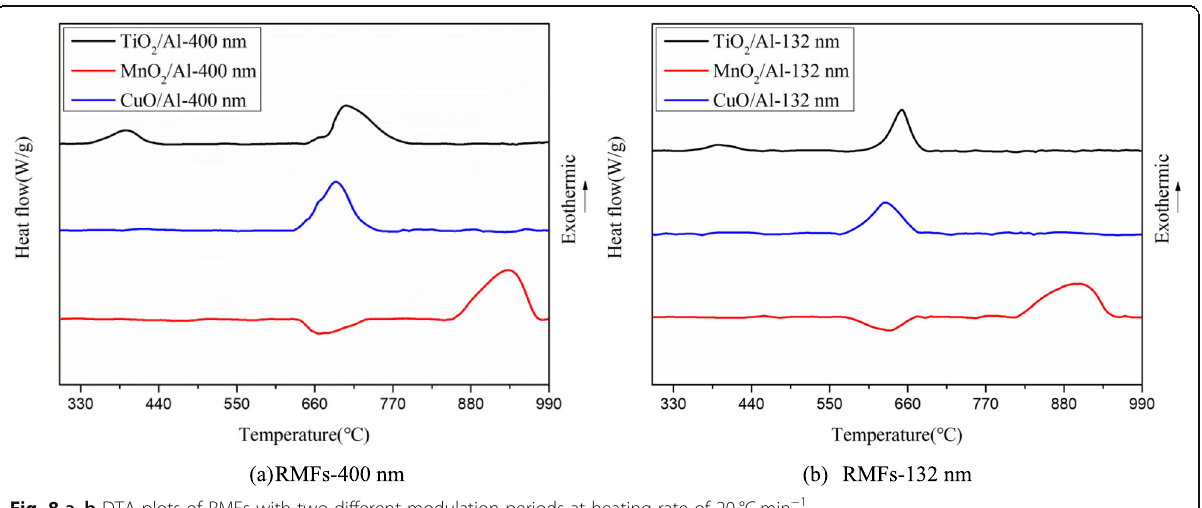
Fig. 8 a , b DTA plots of RMFs with two different modulation periods at heating rate of 20 °C min −